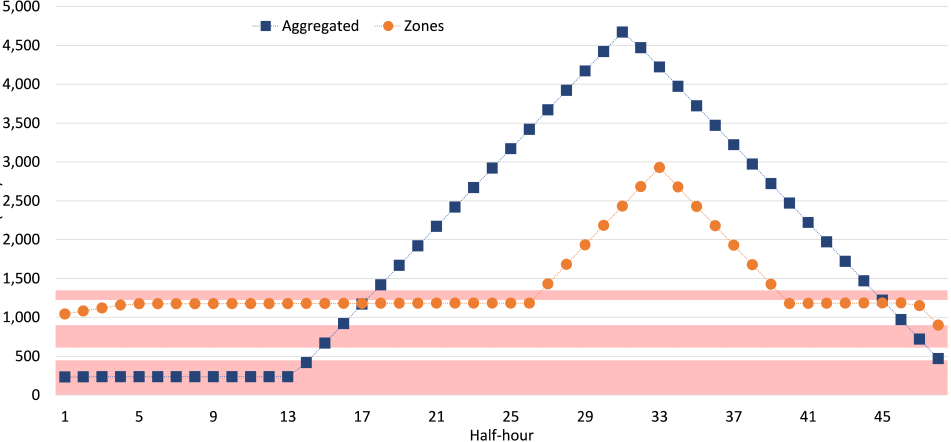
Figure 9. Belo Monte’s generation in the first trial of Case 9 for models aggregated and zones. The plant’s forbidden zones are highlighted in light red.